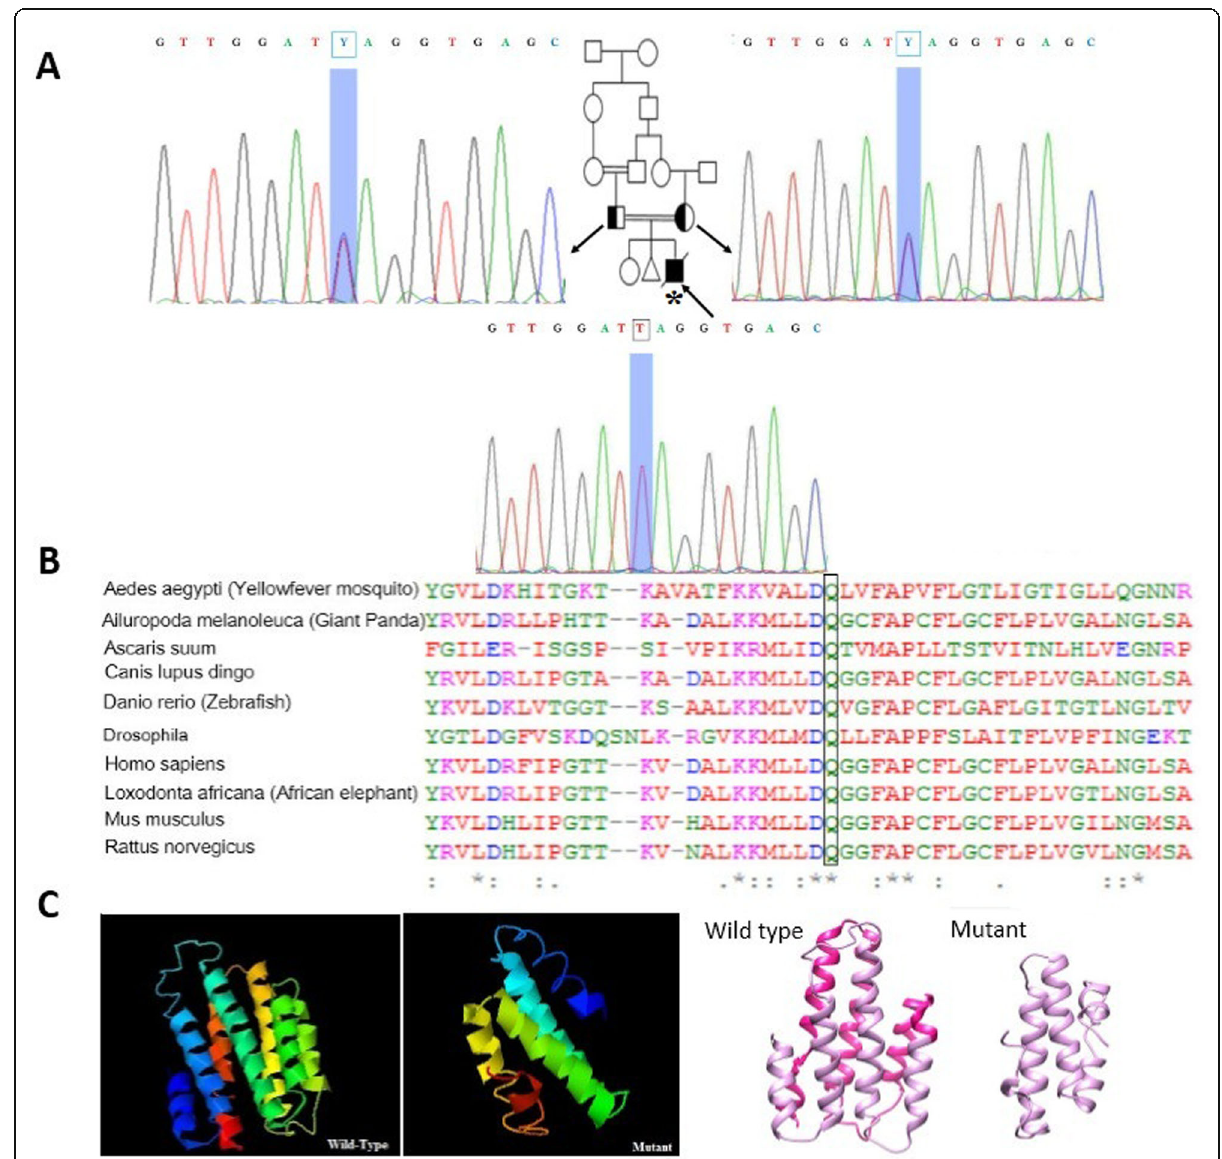
Fig. 4 a Family III pedigree and sequence chromatograms. Both parents are heterozygous and the affected proband is homozygous for this stop- gain mutation in MPV17 gene. The proband is marked by an asterisk. b Comparative amino acid alignment of MPV17 protein across different kingdoms. The conserved glutamine residue is shown in the box. c Protein structure was predicted by I-TASSER server for 3D protein structure prediction. The secondary structure of protein is changed as a result of the mutation. The deleted region is showed in